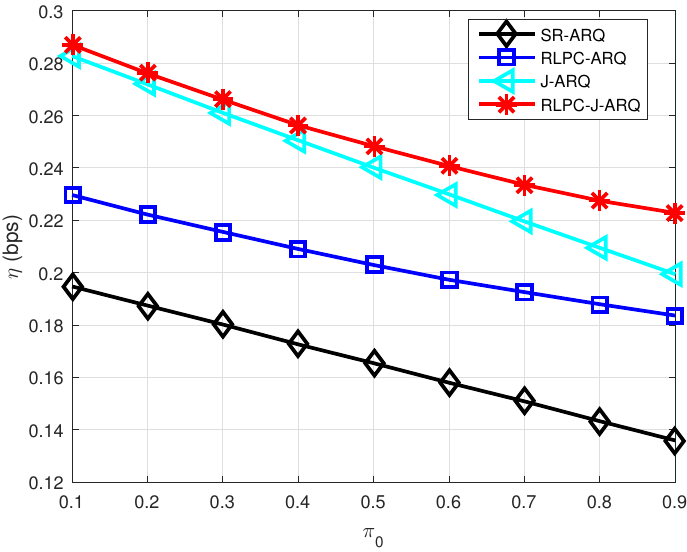
Figure 6. Throughput efficiency as a function of the steady-state probability π 0